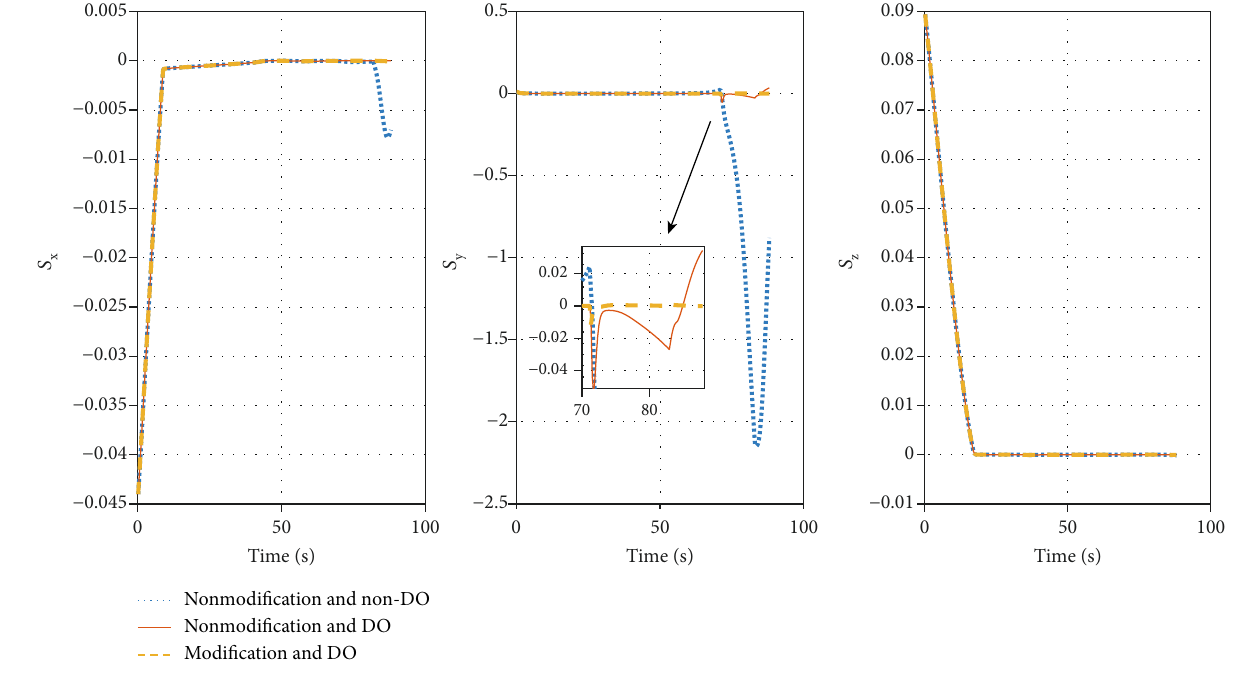
Figure 13: Comparisons of the sliding manifold components.